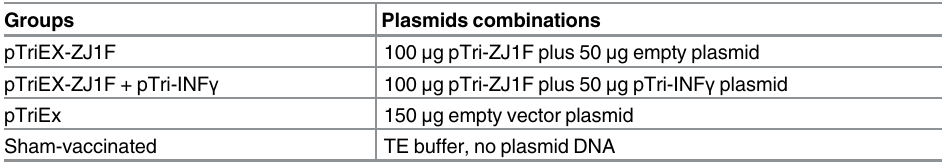
Table 1. DNA-vaccine groups and plasmid